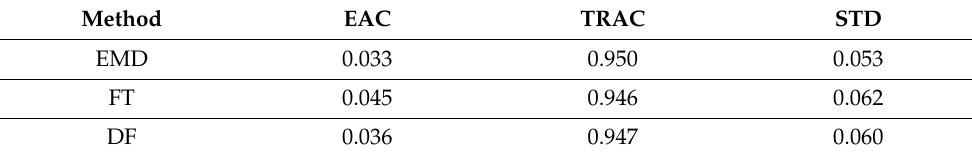
Table 2. Indexes of EMD, FT and